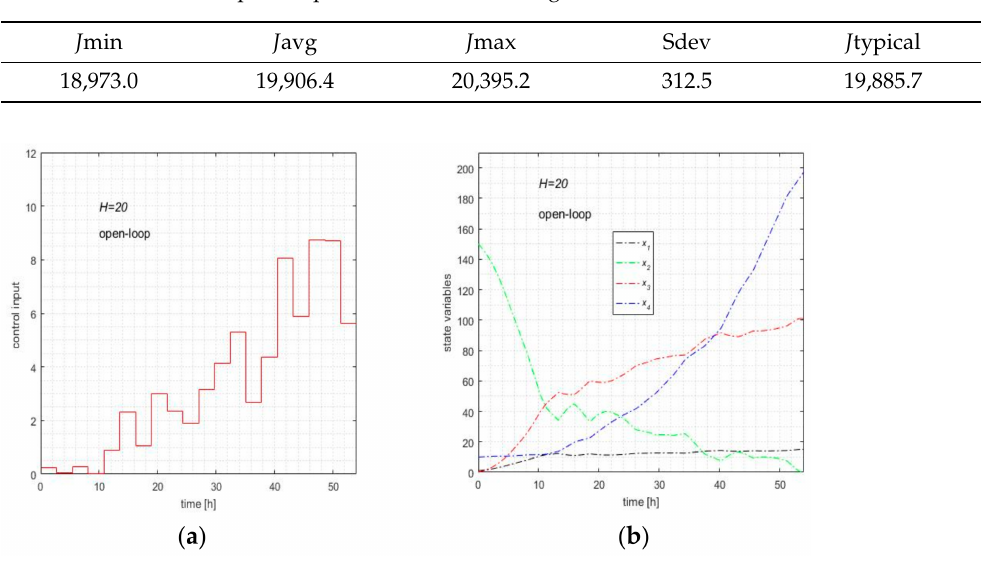
Table 4. Results of the open-loop simulation series using EAv0.